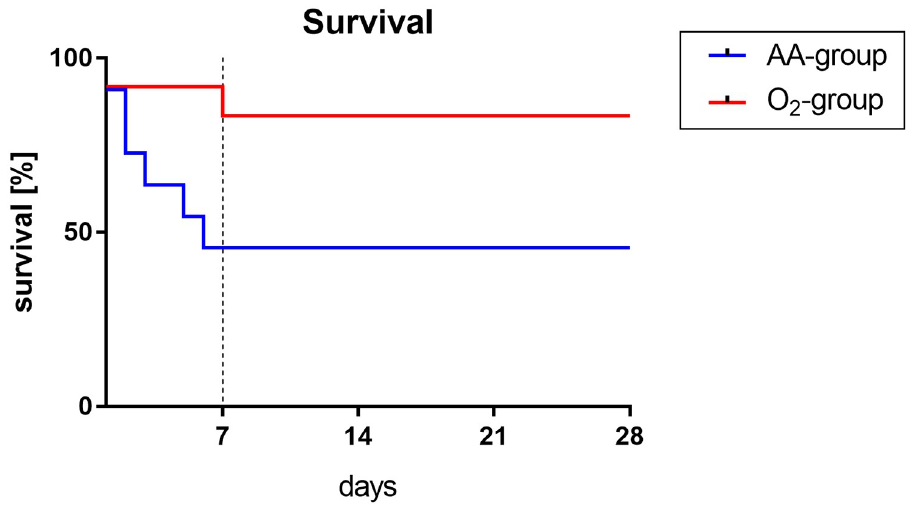
Fig 1. 28-day survival of rats after KX anaesthesia with (O 2 group) or without (AA group) additional oxygen insufflation. The survival curve (Kaplan-Meier analysis) revealed that the survival rate during the follow-up period of 28 days was significantly higher in rats who received additional oxygen insufflation intra- and postoperatively (O 2 group) compared to rats who only breathed ambient air peri- and intraoperatively (AA group) (p = 0.036).